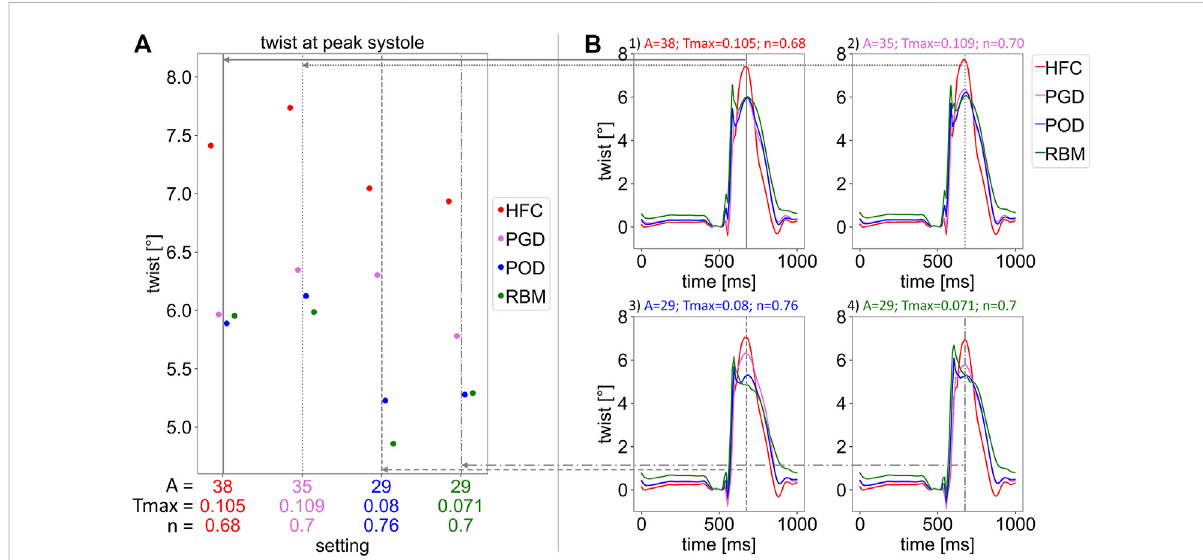
FIGURE 8 Twist relative to end-diastole. Subplot (A) shows the twist in end-systole at 675 ms after the initial state in diastasis, for the four parameter settings listed on the horizontal axis and marked by vertical, gray lines. Each setting was obtained by parameter optimisation with one interpolated fi ber fi eld (with interpolation methods: HFC (red), PGD (violet), POD (blue), and RBM (green)). For each setting, simulations with each fi ber fi eld, obtained by the four interpolation methods, were performed. The resulting twist is indicated by the 4 markers for each parameter setting. In Subplot (B) , the twist over the cardiac cycle is shown. Each Subplot (1 – 4) corresponds to one parameter setting (optimized to: 1: HFC, 2: PGD, 3: POG, 4: RBM), respectively. All plots show the twist for each interpolated fi ber fi eld. The gray vertical lines indicate the time point evaluated in Subplot (A)